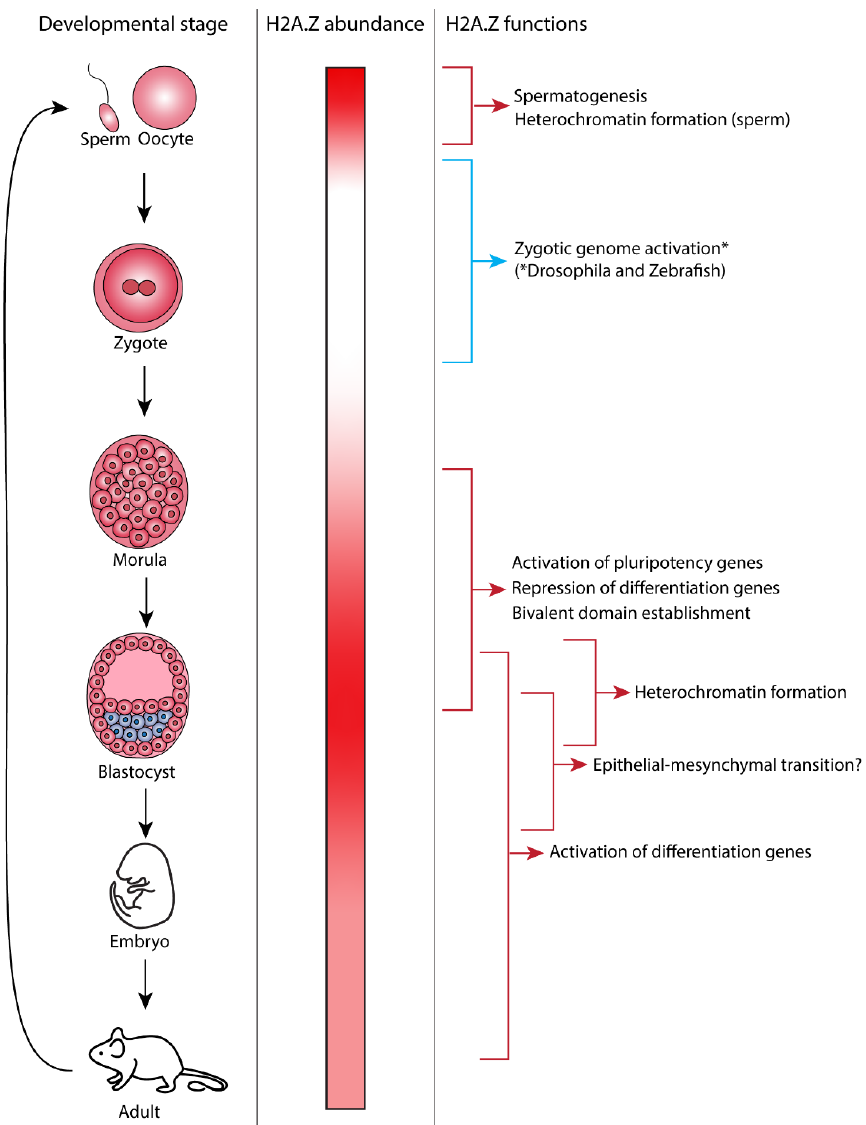
Figure 1. Developmental-stage-specific functions of H2A.Z. The different stages of mouse develop- ment are shown in the left panel. The middle panel shows the relative abundance of H2A.Z protein in each developmental stage. Maternal H2A.Z is present in the gamete and becomes depleted until H2A.Z becomes highly expressed in the blastocyst stage. Differentiation is associated with a decrease in H2A.Z abundance. The right panel shows the developmental processes that H2A.Z has been found to play a role in and depicts when during mouse development these processes occur. * Note that while this figure depicts mouse development, a direct role of H2A.Z in zygotic genome activation has only been shown in Drosophila and zebrafish to date